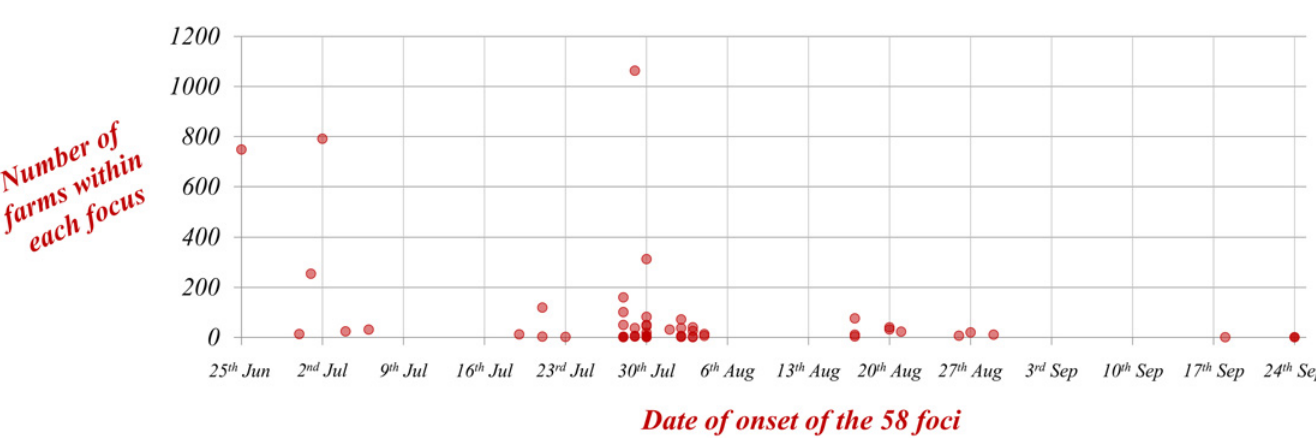
PLOS ONE | DOI:10.1371/journal.pone.0151151 March 10,